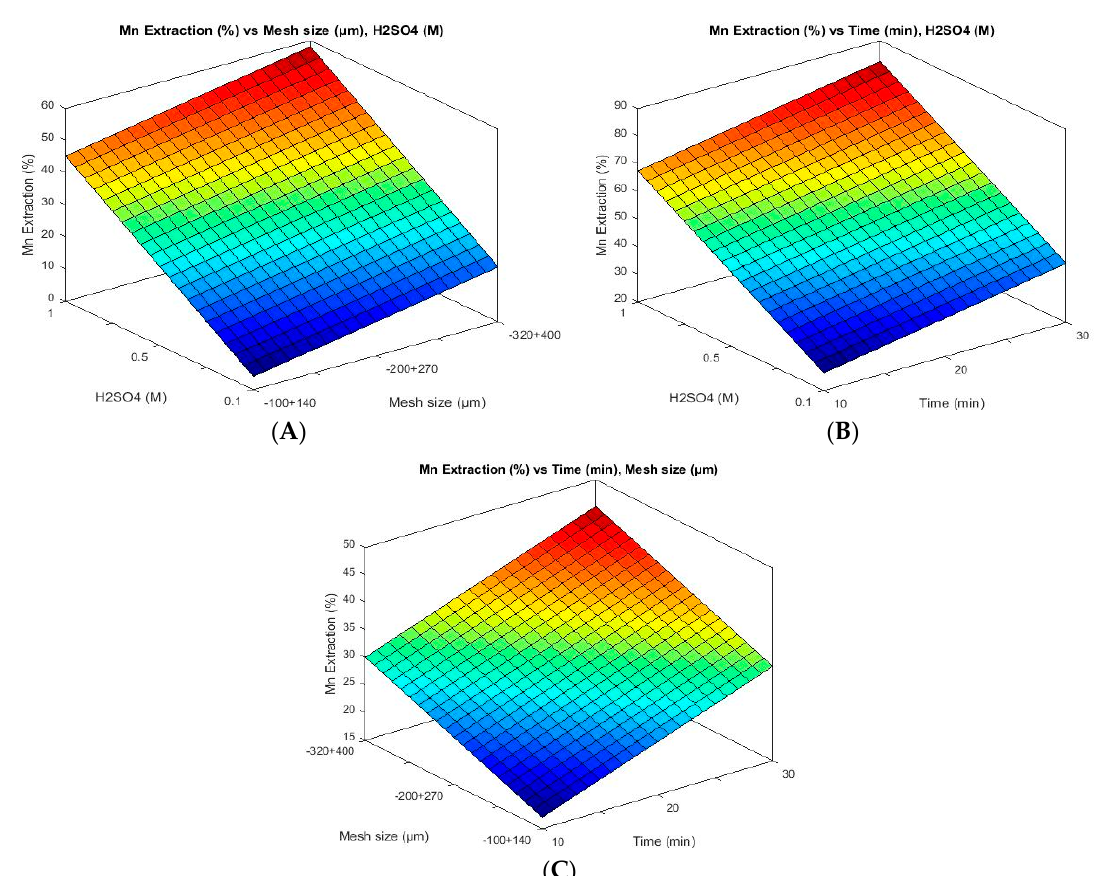
Figure 8. p statistic of the relationship between the Y and X variables in the model.